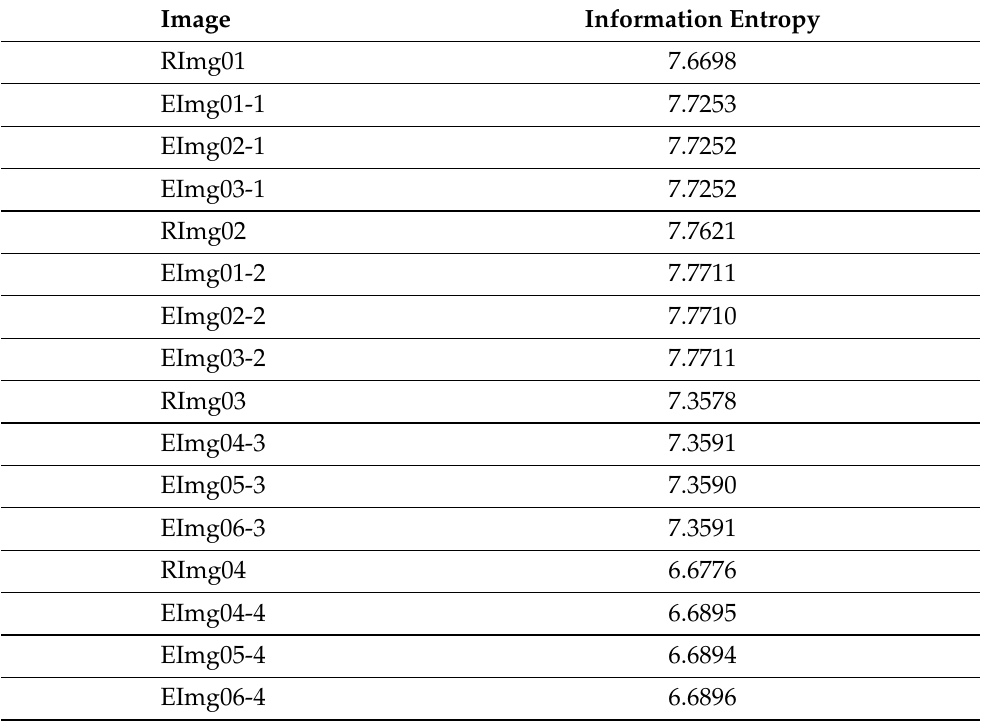
Table 5. Information entropy for reference and visual encrypted images.